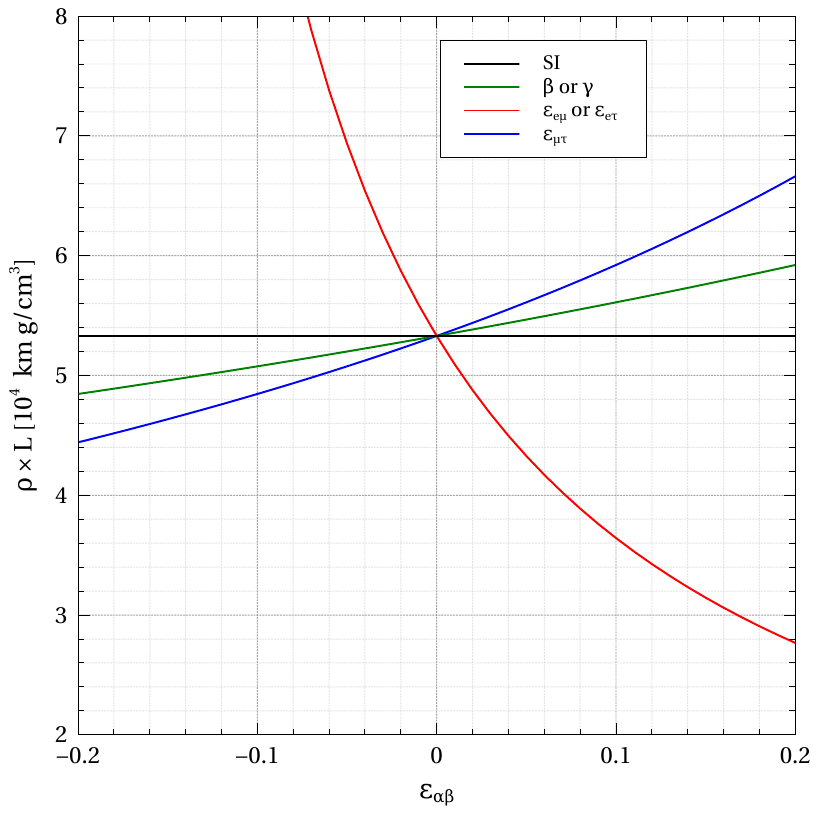
Figure 12 . The product of the baseline ( L ) and the corresponding matter density ( ρ ) for which ν µ → ν e transition probability attains the maximum value (see eq. (7.10)) as a function of various NSI parameters having strength in the range [ − 0 . 2 : 0 . 2] . The solid black curve shows the SI case while the other colored curves correspond to the cases considering one NSI parameter at-a-time, as shown in the legend. The three-flavor oscillation parameters in vacuum are taken from table 2 with a choice of θ = 45 ◦ and 23